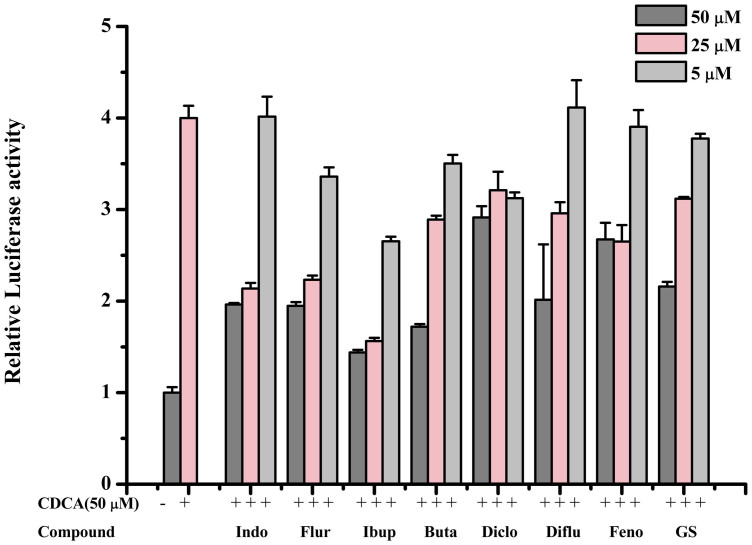
Concentration-response effects of NSAIDs on FXR transactivation inhibition induced by CDCA.The luciferase reporter assay was carried out in 293T transiently transfected with pCMX-FXRα, pCDNA3.1-RXRα, luciferase reporter plasmid pGL3-FXRE-Luc and a Renilla luciferase expression plasmid (as transfection control) in mammalian transactivation assays. The system was stimulated with 50 μM CDCA alone or in combination with different concentrations of NSAIDs (indomethacin was indicated as Indo, flurbiprofen was indicated as Flur, ibuprofen was indicated as Ibup, phenylbutazone was indicated as Buta, diclofenac was indicated as Diclo, diflunisal was indicated as Diflu, fenoprofen was indicated as Feno). Data are means of three experiments carried out in triplicate.